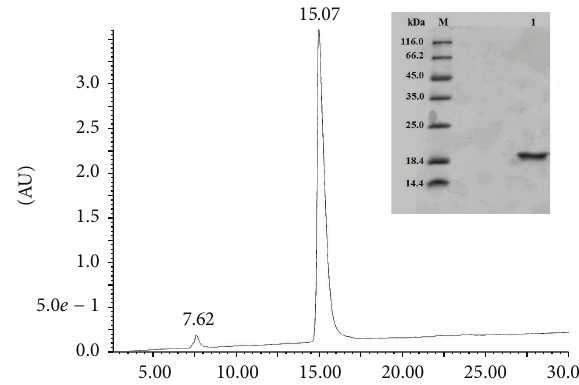
Figure 1: Reverse phase chromatograph, HPLC system 𝜇 -Bondapak C18. SDS-PAGE (15%) from reverse phase chromatography on C18. (M) Molecular mass standards; (1) rBbKI (30 𝜇 g) treated with 𝛽 - mercaptoethanol.